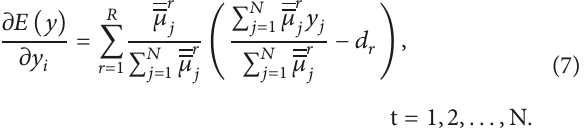
Table 1: The results of Fuzzy Control Systems with TF and TF ⋅ ICF features.